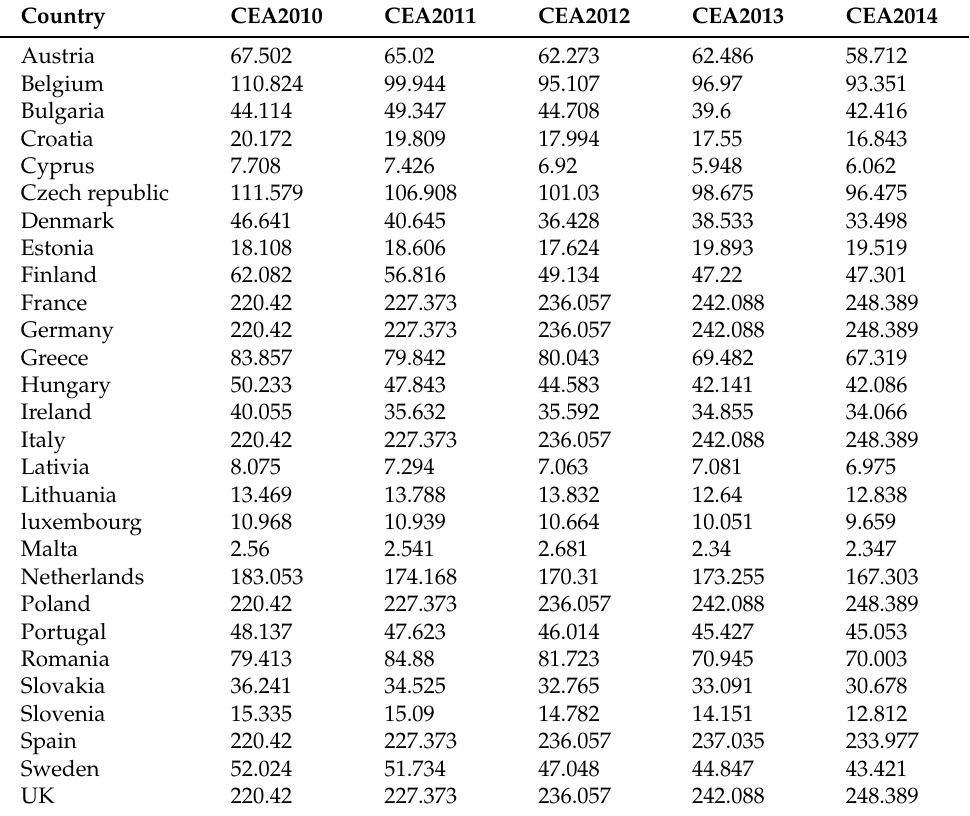
Table A2. Allocation vectors provided by CEA solution for each year in the interval 2010–2014 (values are in millions of tons of CO 2 ).